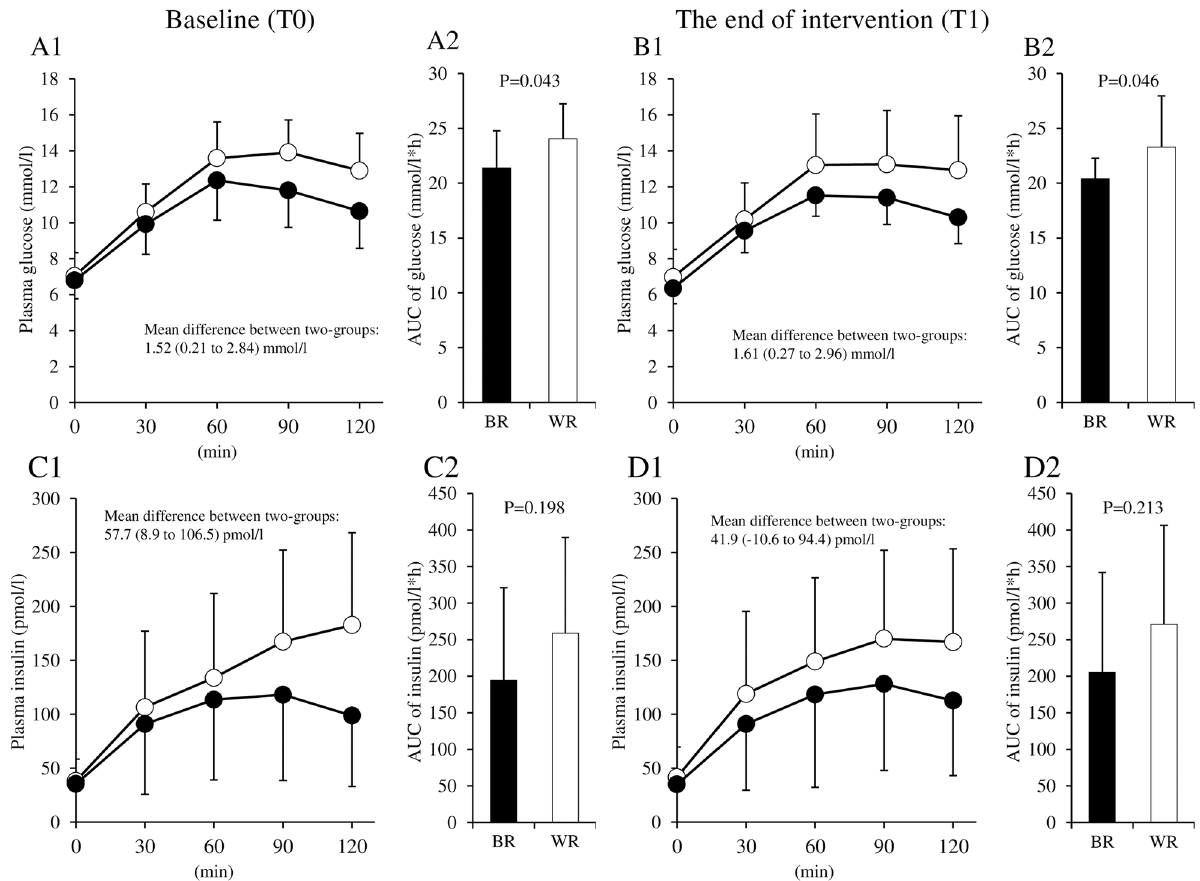
Fig 3. Changes in plasma glucose and insulin levels during the rice tolerance test. Levels of plasma glucose(A1, B1) and the area under the curve (AUC) for plasma glucose(A2, B2) duringthe rice tolerancetest at baseline(T0: left graph) and at the end of intervention (T1: right graph) for estimatingthe postprandial state duringthe intervention. Levels of plasma insulinand AUC were measured duringthe rice tolerancetest (C1–2, D1–2). BR, brown rice diet group (black circle and box), WR, white rice diet group (white circle and box).